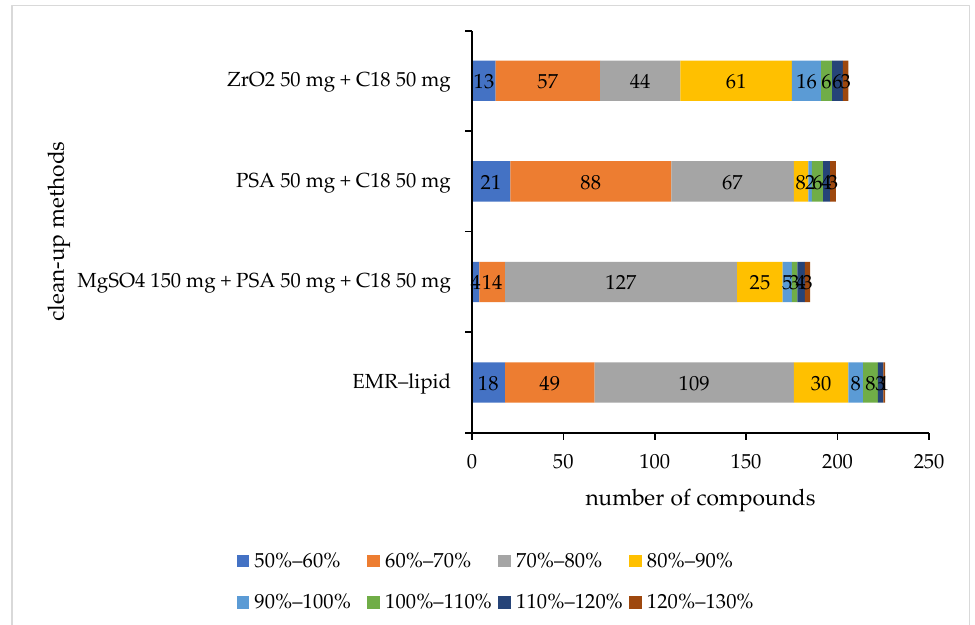
Figure 3. Number of compounds in recovery ranges with different clean-up methods. Compared to the combination of 50 mg of PSA and 50 mg of C18, when MgSO 4 was added, the number of compounds with recovery rates between 70% and 120% was increased to 164. However, 90% of sulfonamides obtained a poor recovery rate that was below 50%, which means adding MgSO 4 can strongly affect the extraction of sulfonamides. This result is in accordance with the results of the study performed by Chunna Guo et al., which indicated that when d-SPE was used with a combination of PSA and